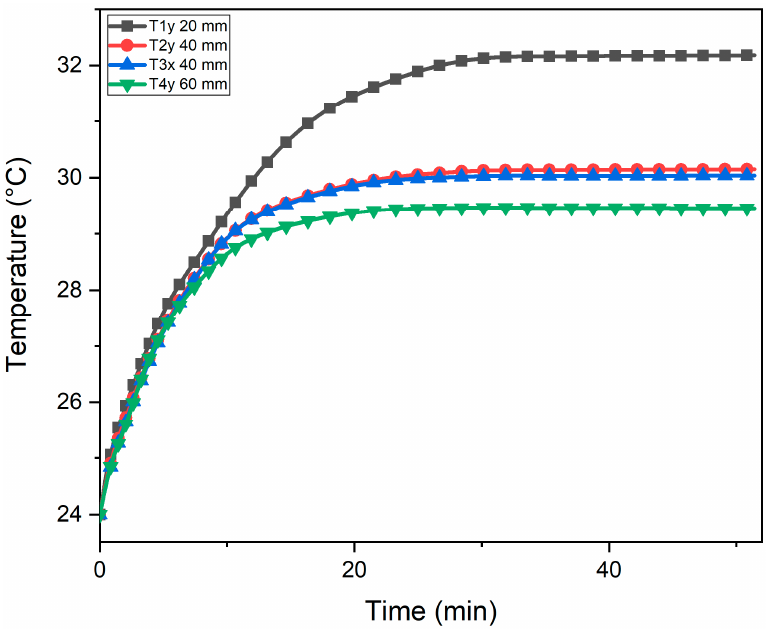
Figure 11. Temperature profile along the x - and y -axis for reverse flow configuration with power input of 20